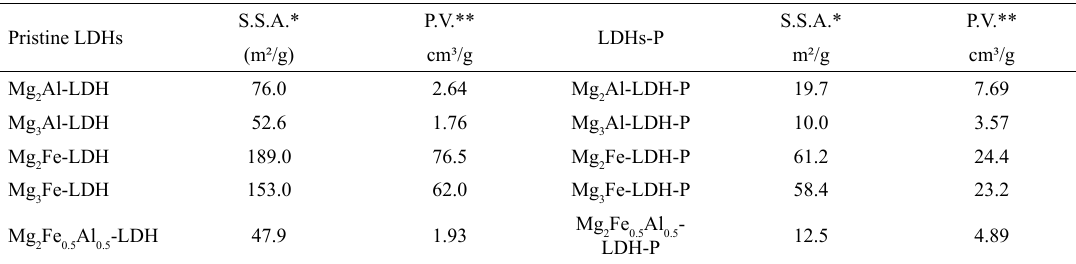
Table 4. Specific surface area and pore volume of different LDHs Pristine